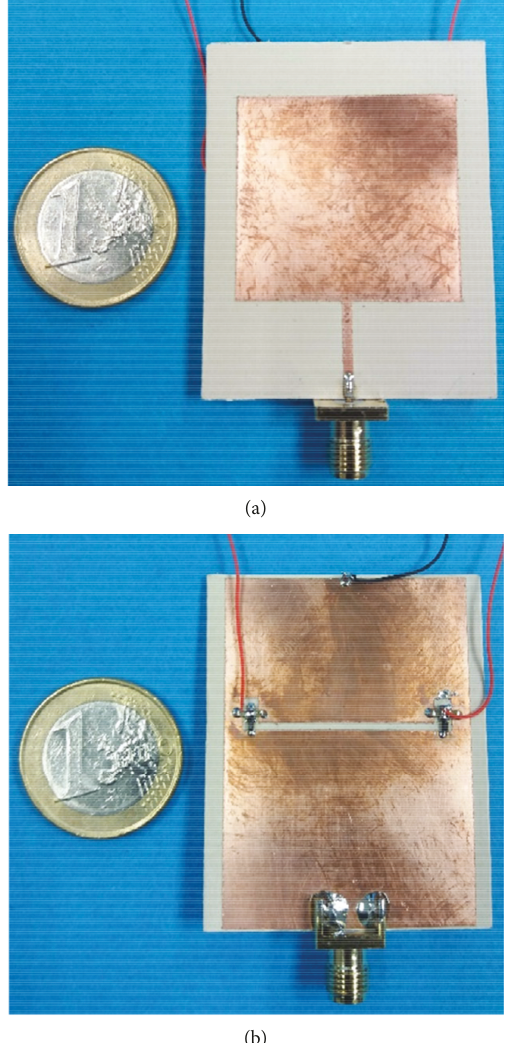
Figure 15: Fabricated antenna with DC bias circuit. (a) Front view. (b) Back view.